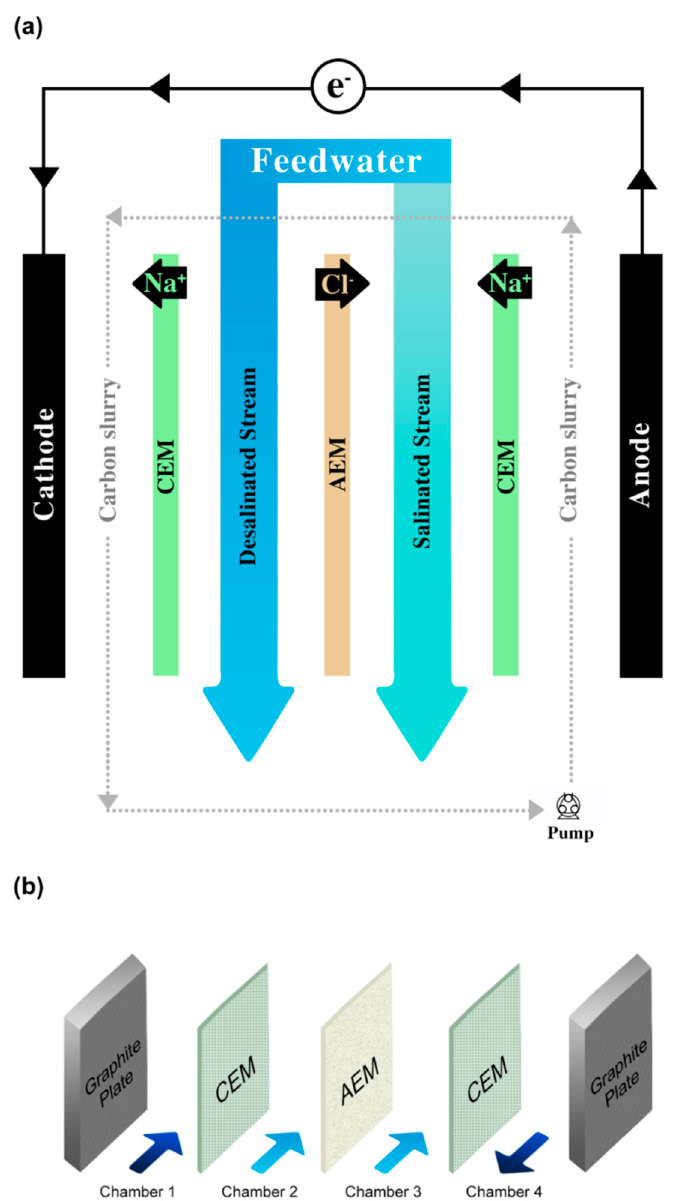
Figure 1. ( a ) Top view and ( b ) side view of the schematic of FCDI cell structure and desalination mechanism.